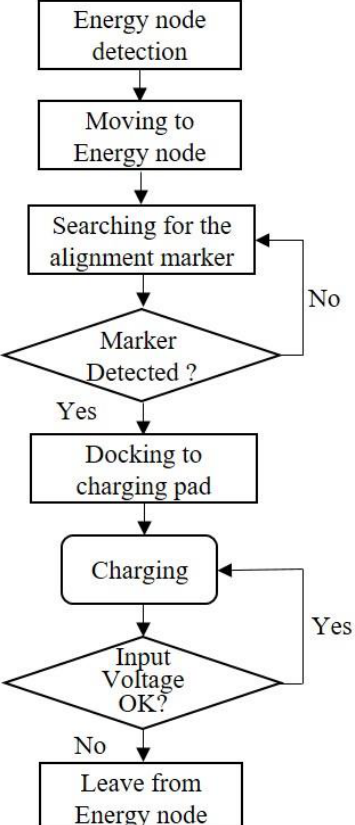
Figure 8. Robot charging process for the experiment .